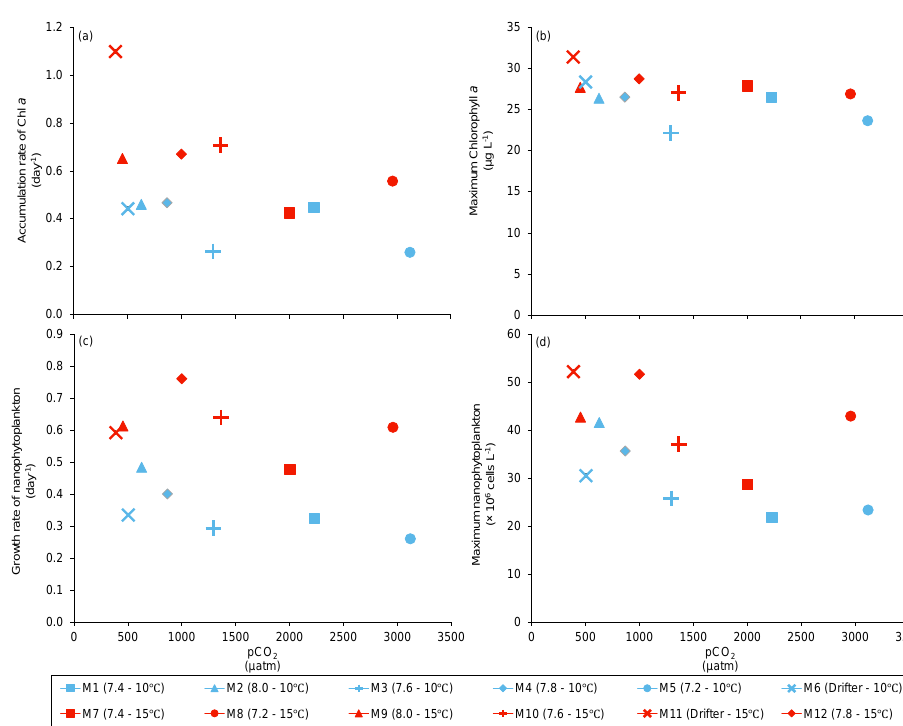
Figure 5. (a) Accumulation rate of Chl a (day 0 to maximum Chl a concentration), (b) maximum Chl a concentrations, (c) growth rate of nanophytoplankton (day 0 to maximum nanophytoplankton abundance), and (d) maximum nanophytoplankton abundance during the experiment. For symbol attribution to treatments, see legends.